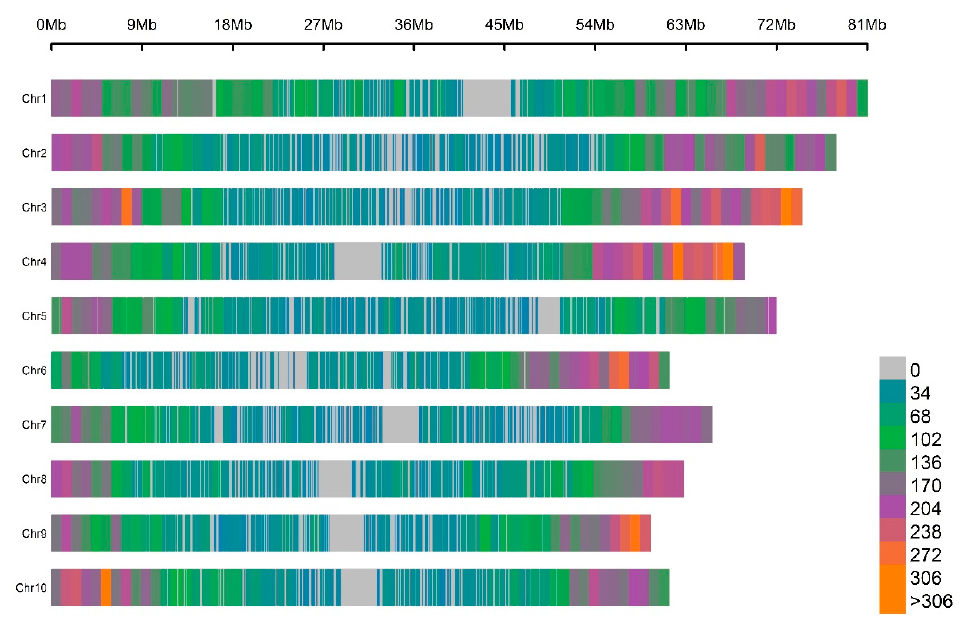
Figure 3. Chromosome-wise density (number of SNPs called) of genotyping-by-sequencing (GBS) SNP markers discovered in the population of 114 sorghum materials evaluated in this work. The color-coded scale bar to the left indicates the respective number of SNPs within 1 Mb window size.